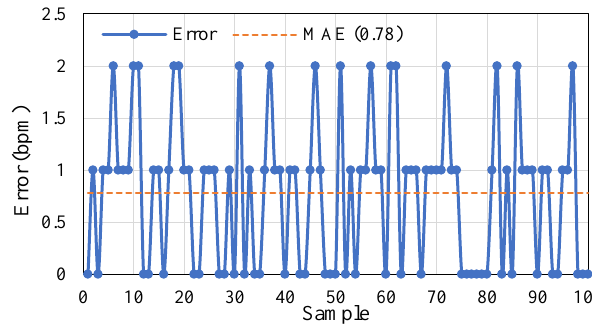
Figure 9. The measurement error of WHR absolute error.